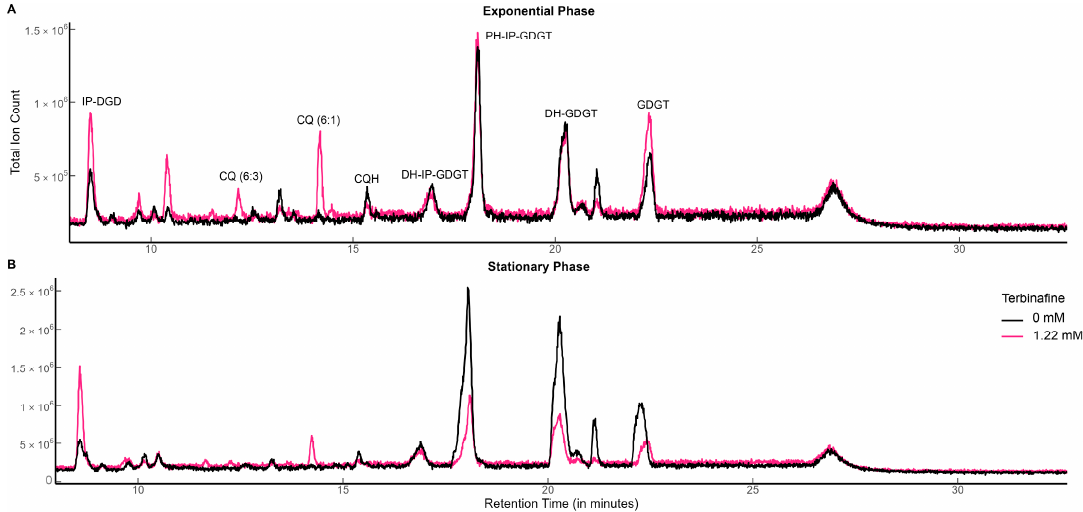
Figure 3. Total ion chromatograms of S. acidocaldarius lipid extracts with and without terbinafine: ( A ) exponential phase and ( B ) stationary phase. TIC was normalized to the amount of lipids using the internal standard DOPG.